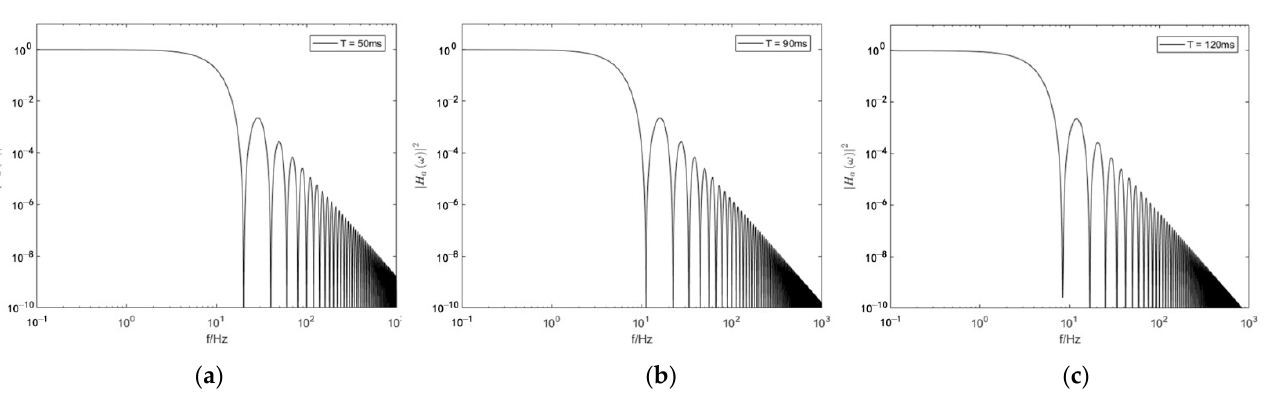
Figure 2. Transfer function spectrum of the reflection mirror vibration noise in an AIG at different time intervals T under the effect of Raman light. ( a ) T = 50 ms, ( b ) T = 90 ms, and ( c ) T = 120 ms.